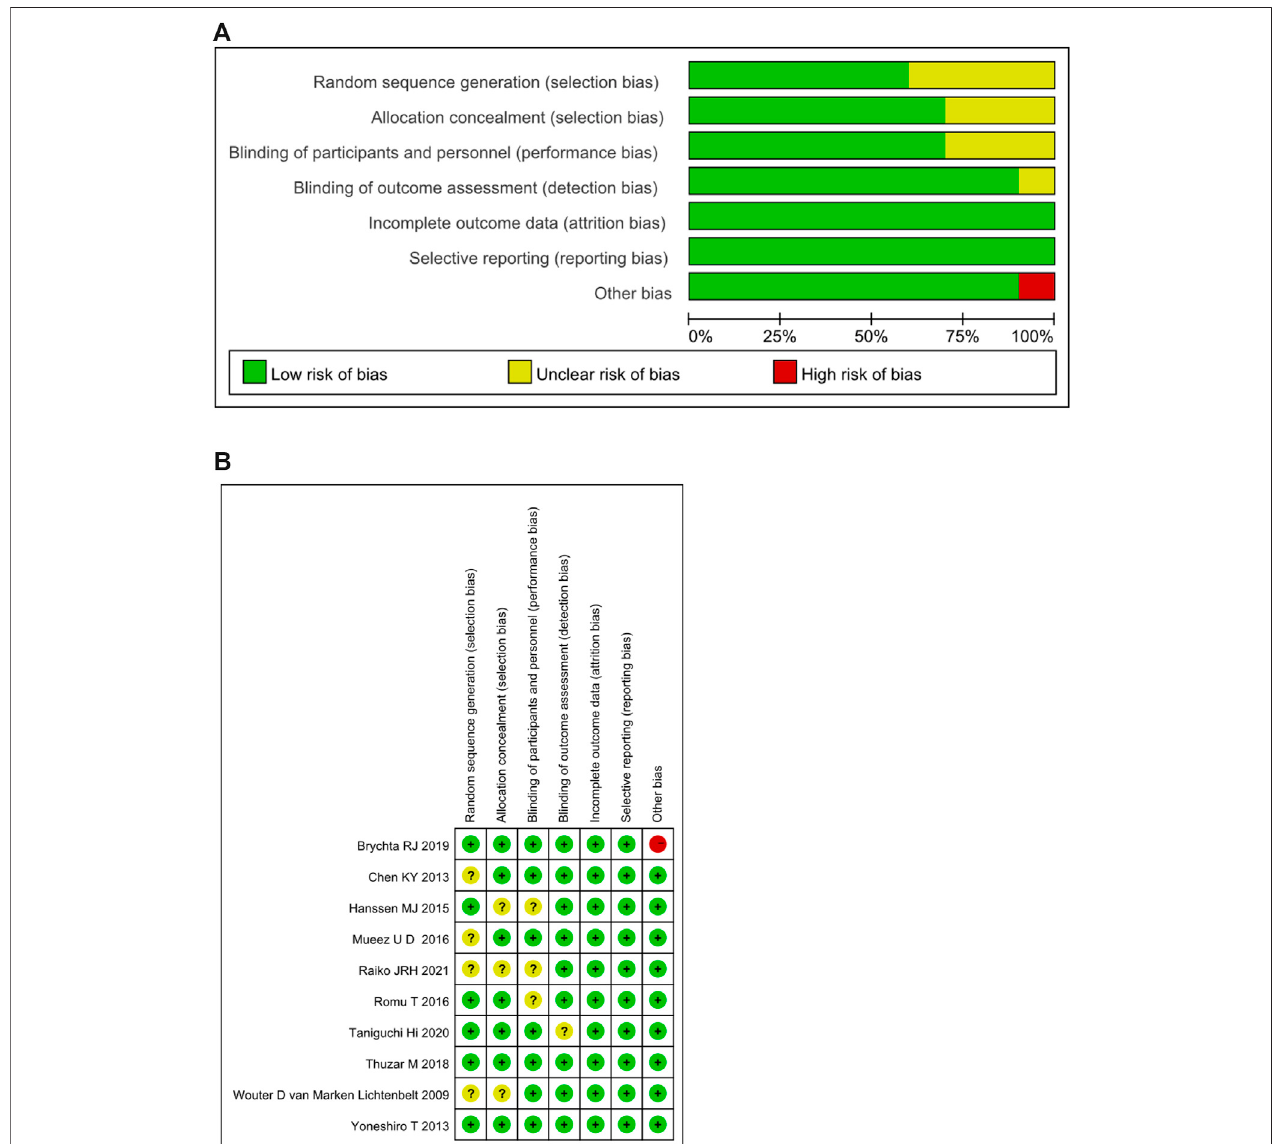
FIGURE2|(A) Summary of risk of bias assessment for randomized controlled trials. (B) Risk of bias assessment for randomized controlled trials. + : low risk of bias; - : high risk of bias; ?: unclear risk of bias.